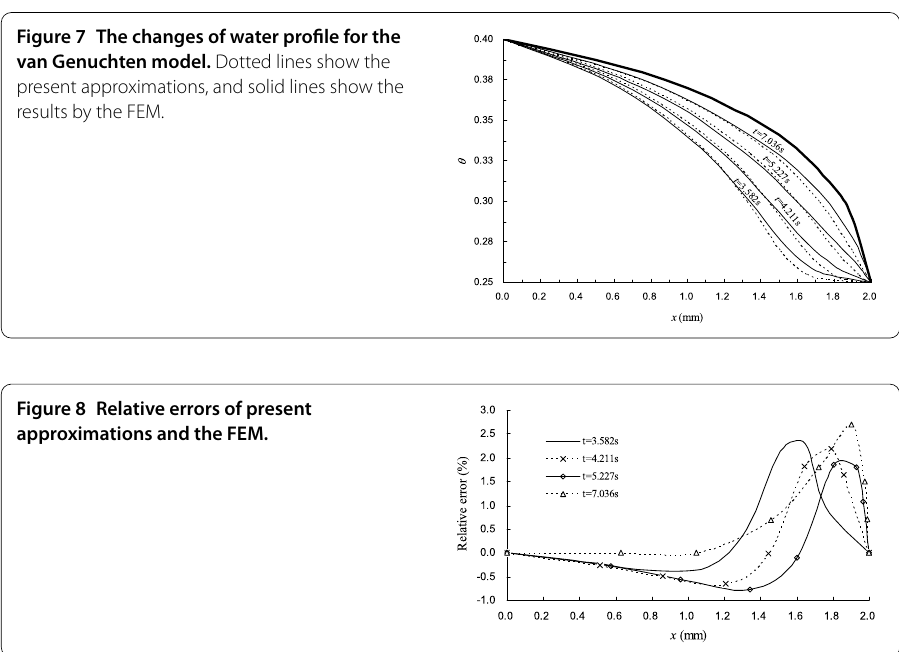
Figure 8 Relative errors of present approximations and the